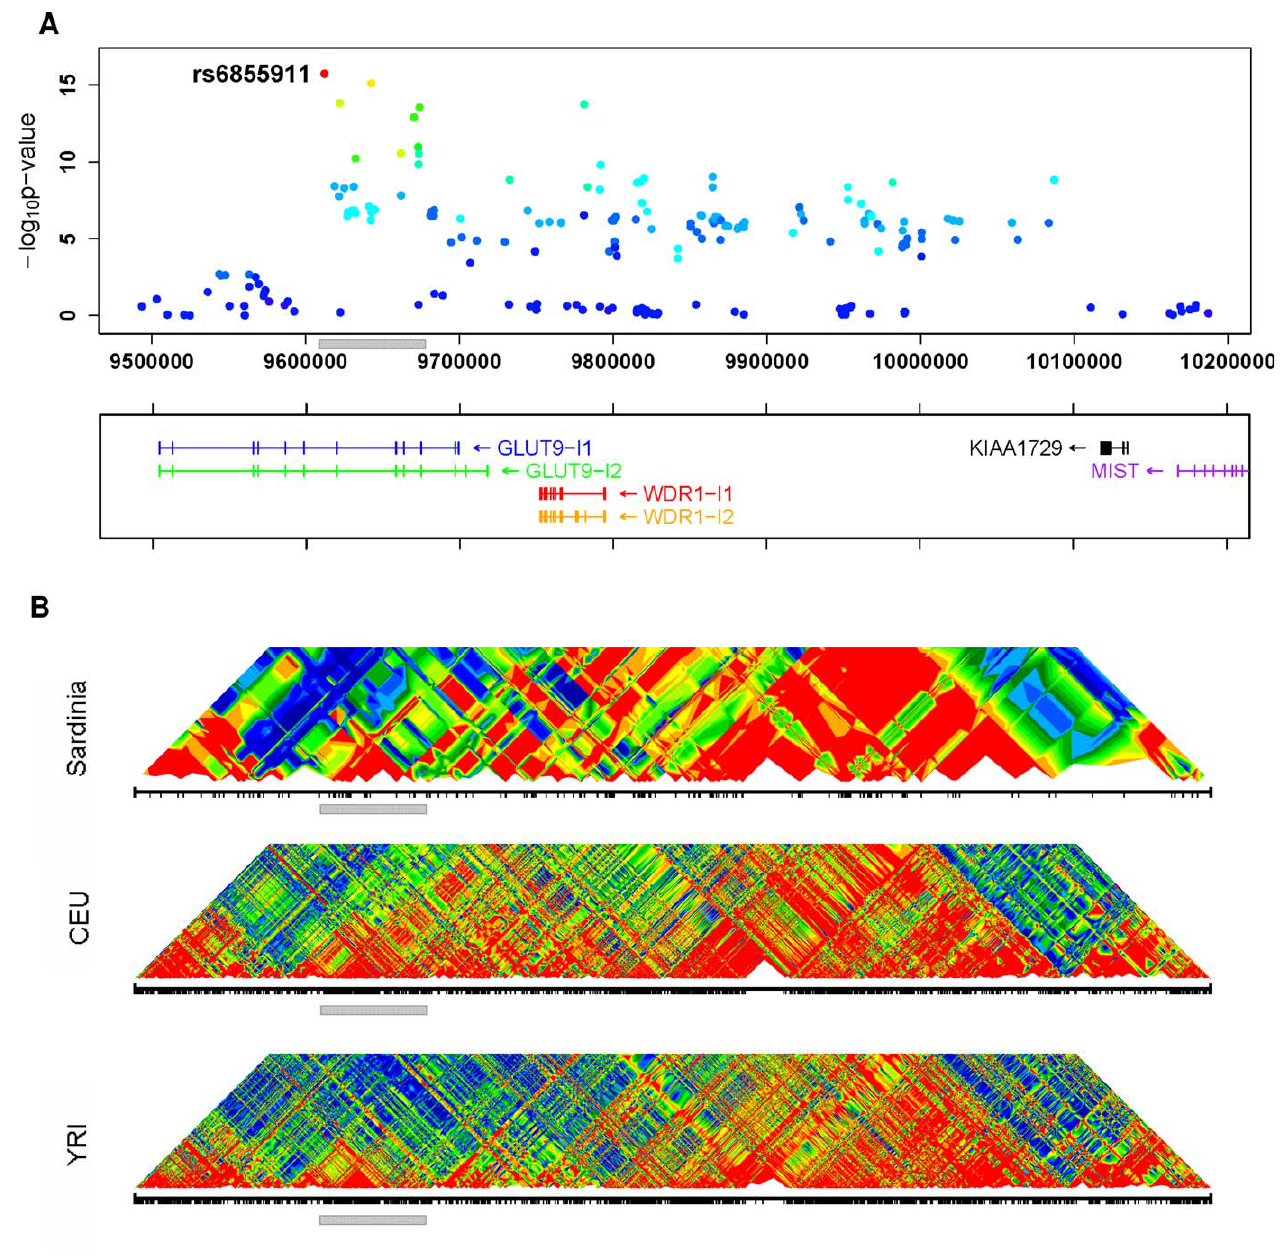
Figure 3. Association Results and Linkage Disequilibrium Patterns in Region Surrounding the GLUT9 Gene (A) Summary of the association between SNPs in the region and UA levels. The SNP showing strongest association (rs6855911) is highlighted. Other SNPs are colored according to their degree of disequilibrium with rs6855911, ranging from high (red), to intermediate (green), to low (blue). Transcripts in the region are indicated at the bottom of the graph, with an arrow indicating the direction of transcription. (B) Patterns of linkage disequilibrium in the region in Sardinia and in two of the HapMap populations (CEU and YRI) [25], where r 2 values are calculated according to [26] and colored as (A). The grey bar marks the region of association and facilitates comparisons between the panels.